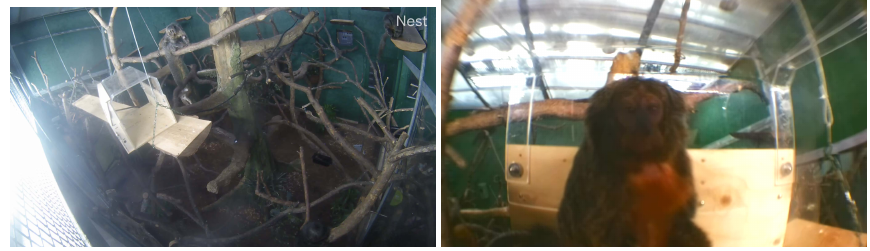
Figure 2. The view from Google Nest and Raspberry Pi